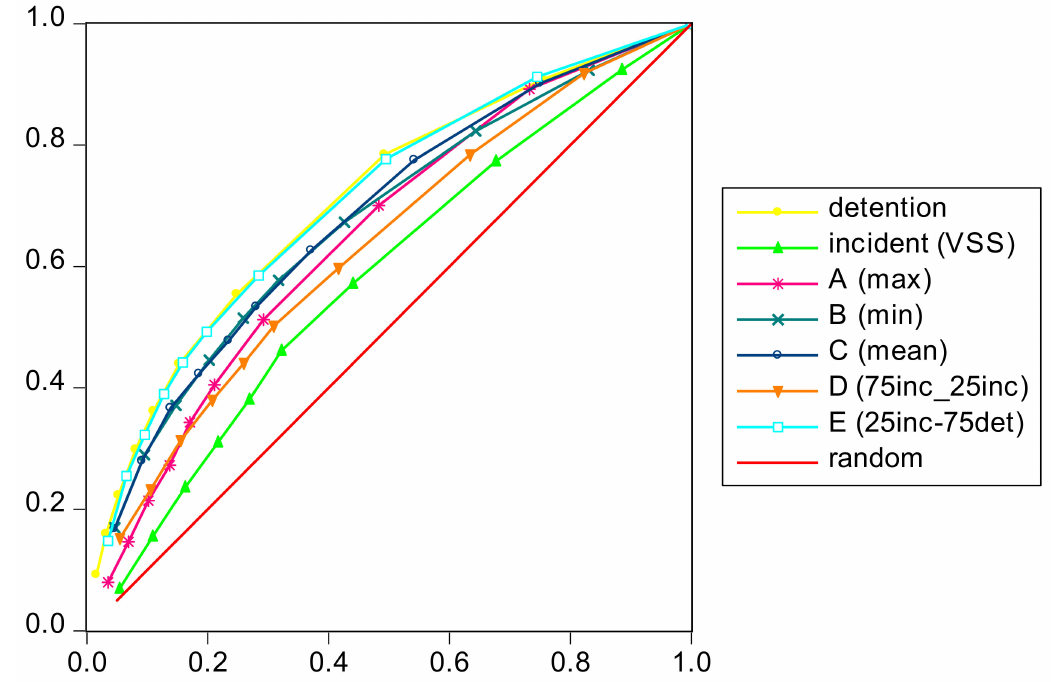
Figure A2. ROC curve—evaluation variable detention: total detentions